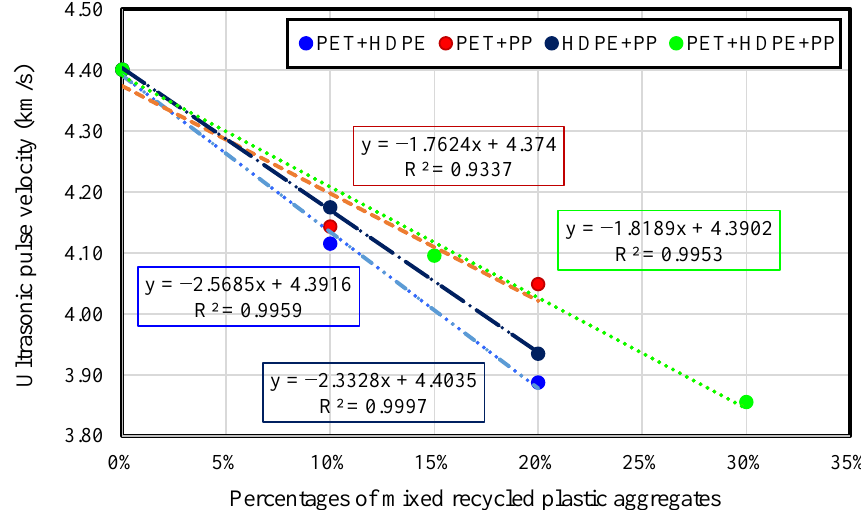
Figure 26. The relationship between the percentage of replacement and UPV.